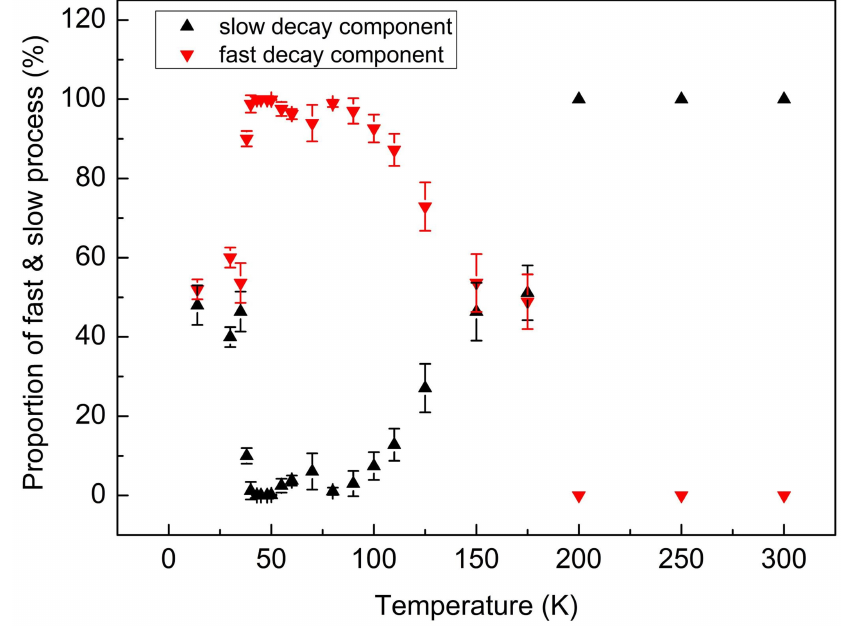
Figure 5. The proportion of slow and fast decay component detected at the maximum emission peak as functions of